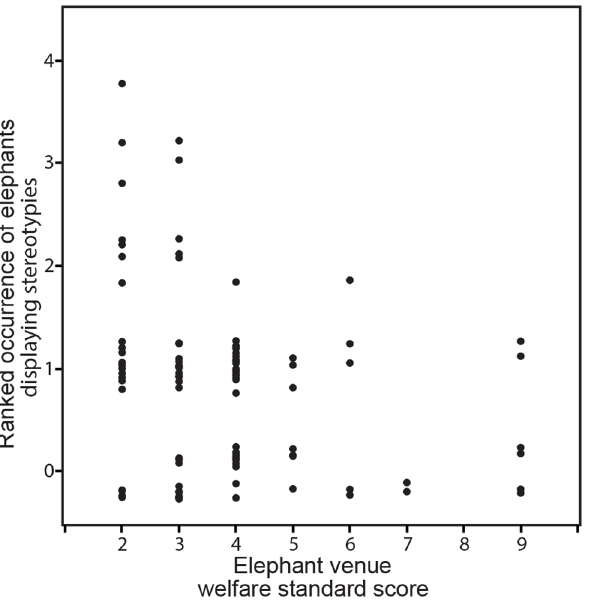
Fig 6. Scatterplot of ranked occurrences of elephants displaying stereotypies at assessed venues against welfare standard scores of these venues. The ranking scale steps are 0 = No animals stereotyping, 1 = < 25% of animals stereotyping, 2 = 25 – 49% of animals stereotyping, 3 = 50 – 75% of animals stereotyping and 4 = > 75% of animals stereotyping. Venues with lower welfare standard scores show a higher occurrence of stereotypies of elephants than venues with higher welfare standard